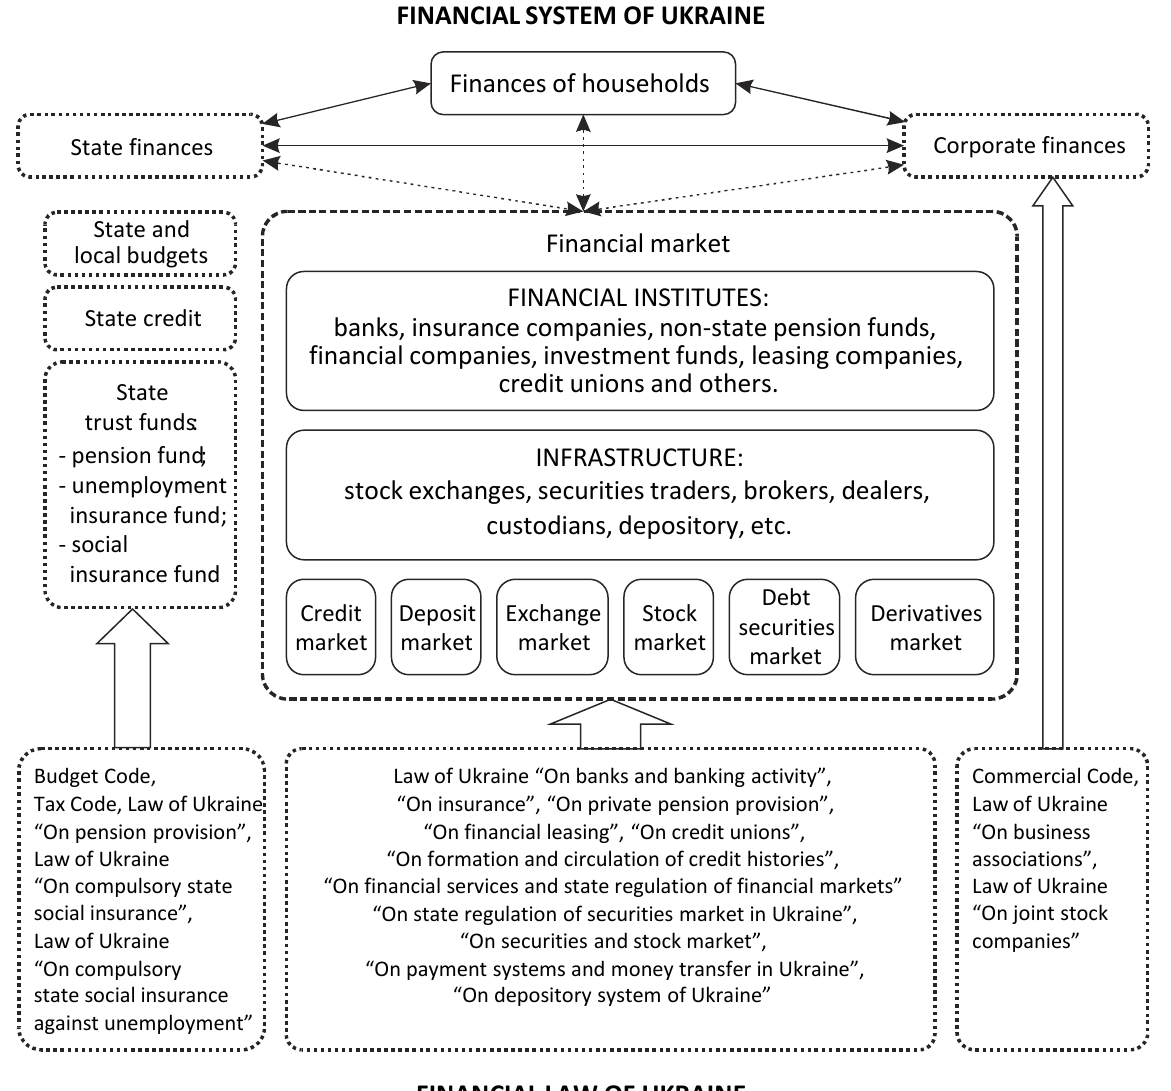
Figure 3. The financial system of Ukraine – harmonization of economic and legal